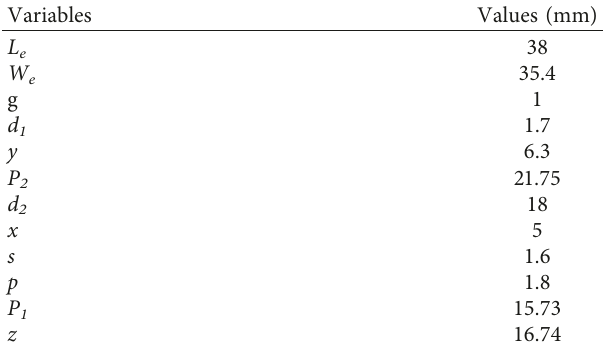
Table 1: The selected values of the modelled sensor. Variables